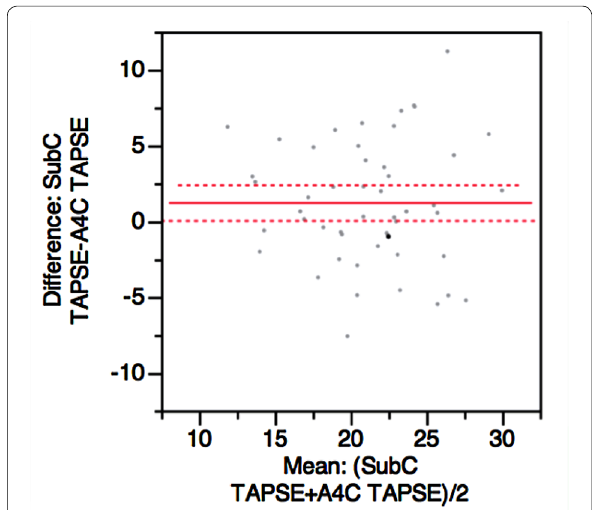
Fig. 3 Bland–Altman plot demonstrating mean difference between A4C and Subcostal TAPSE